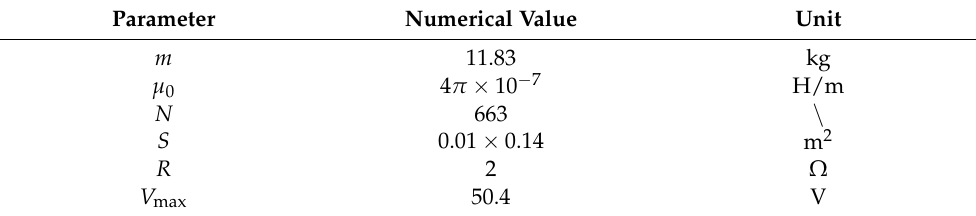
Table 3. Parameters of equally scaled down suspension hardware platform.